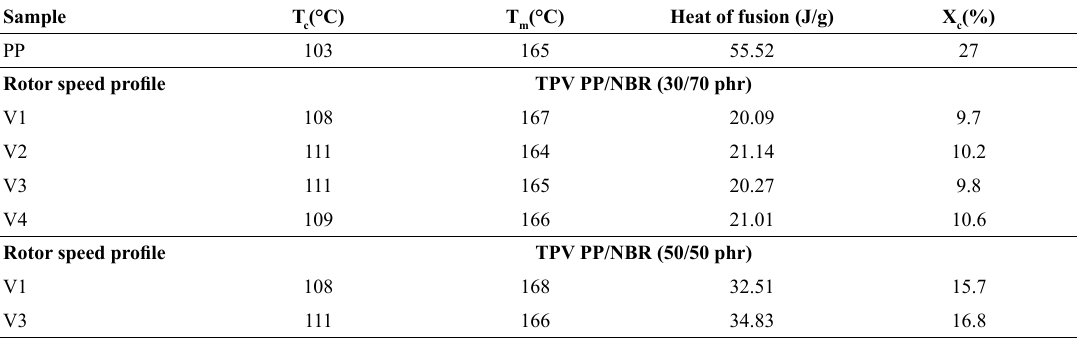
Table 4. Rotor speed effect on the thermal properties of the